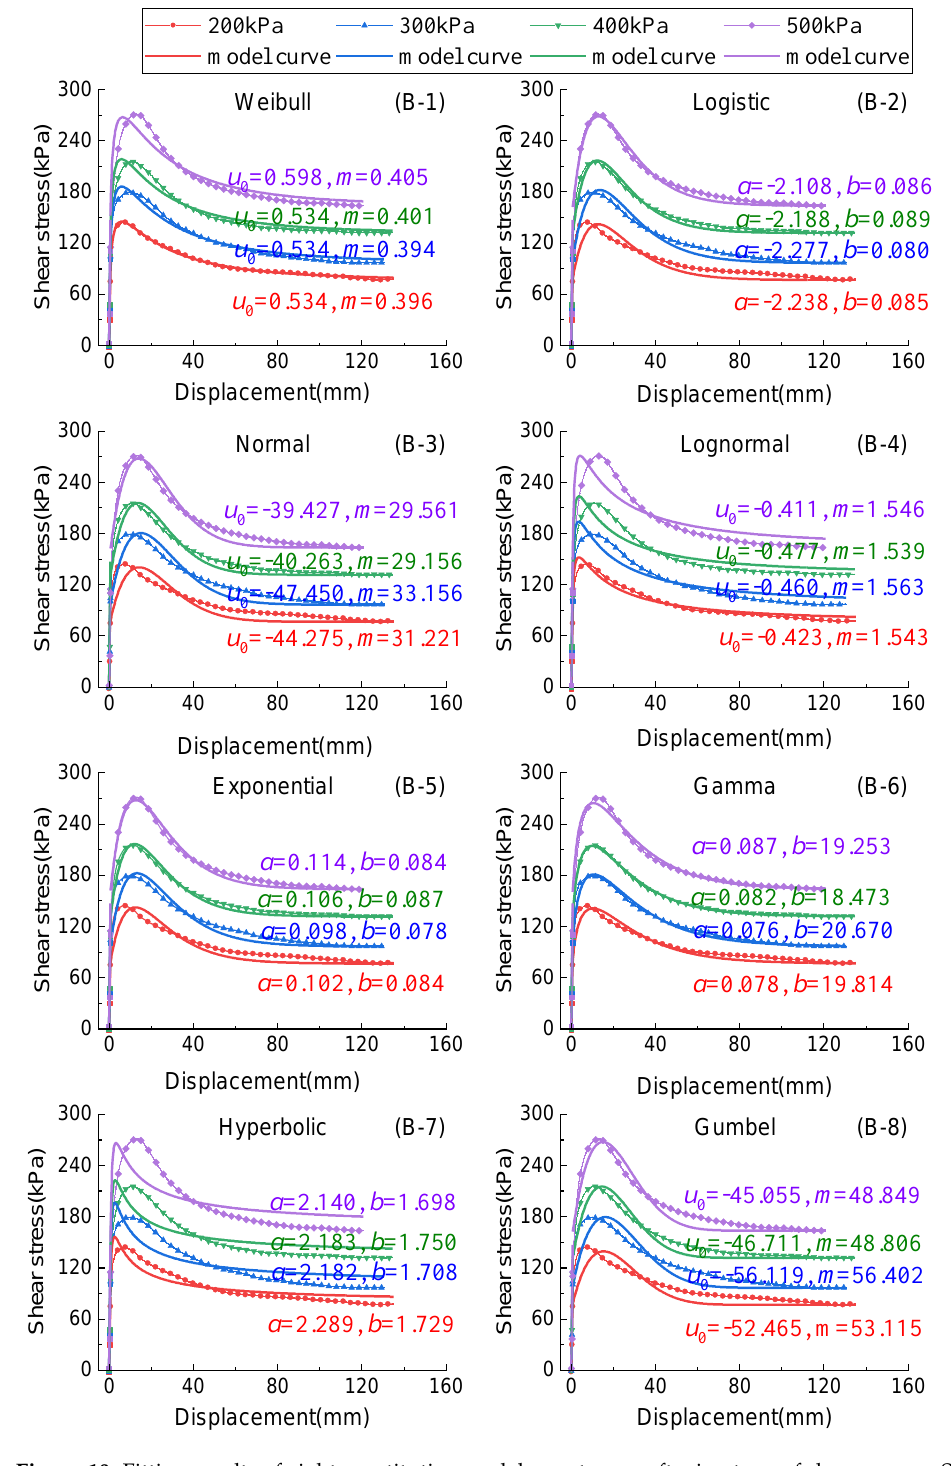
Figure 10. Fitting results of eight constitutive models on strong softening type of shear curves. Series B presents the model curves and experimental data of the slip zone soil from Shizibao landslide representing the strong softening type. ( B-1 ) Weibull-constitutive model; ( B-2 ) logistic-constitutive model; ( B-3 ) normal-constitutive model; ( B-4 ) lognormal-constitutive model; ( B-5 ) exponential-constitutive model; ( B-6 ) Gamma-constitutive model; ( B-7 ) hyperbolic-constitutive model; ( B-8 ) Gumbel-constitutive model.